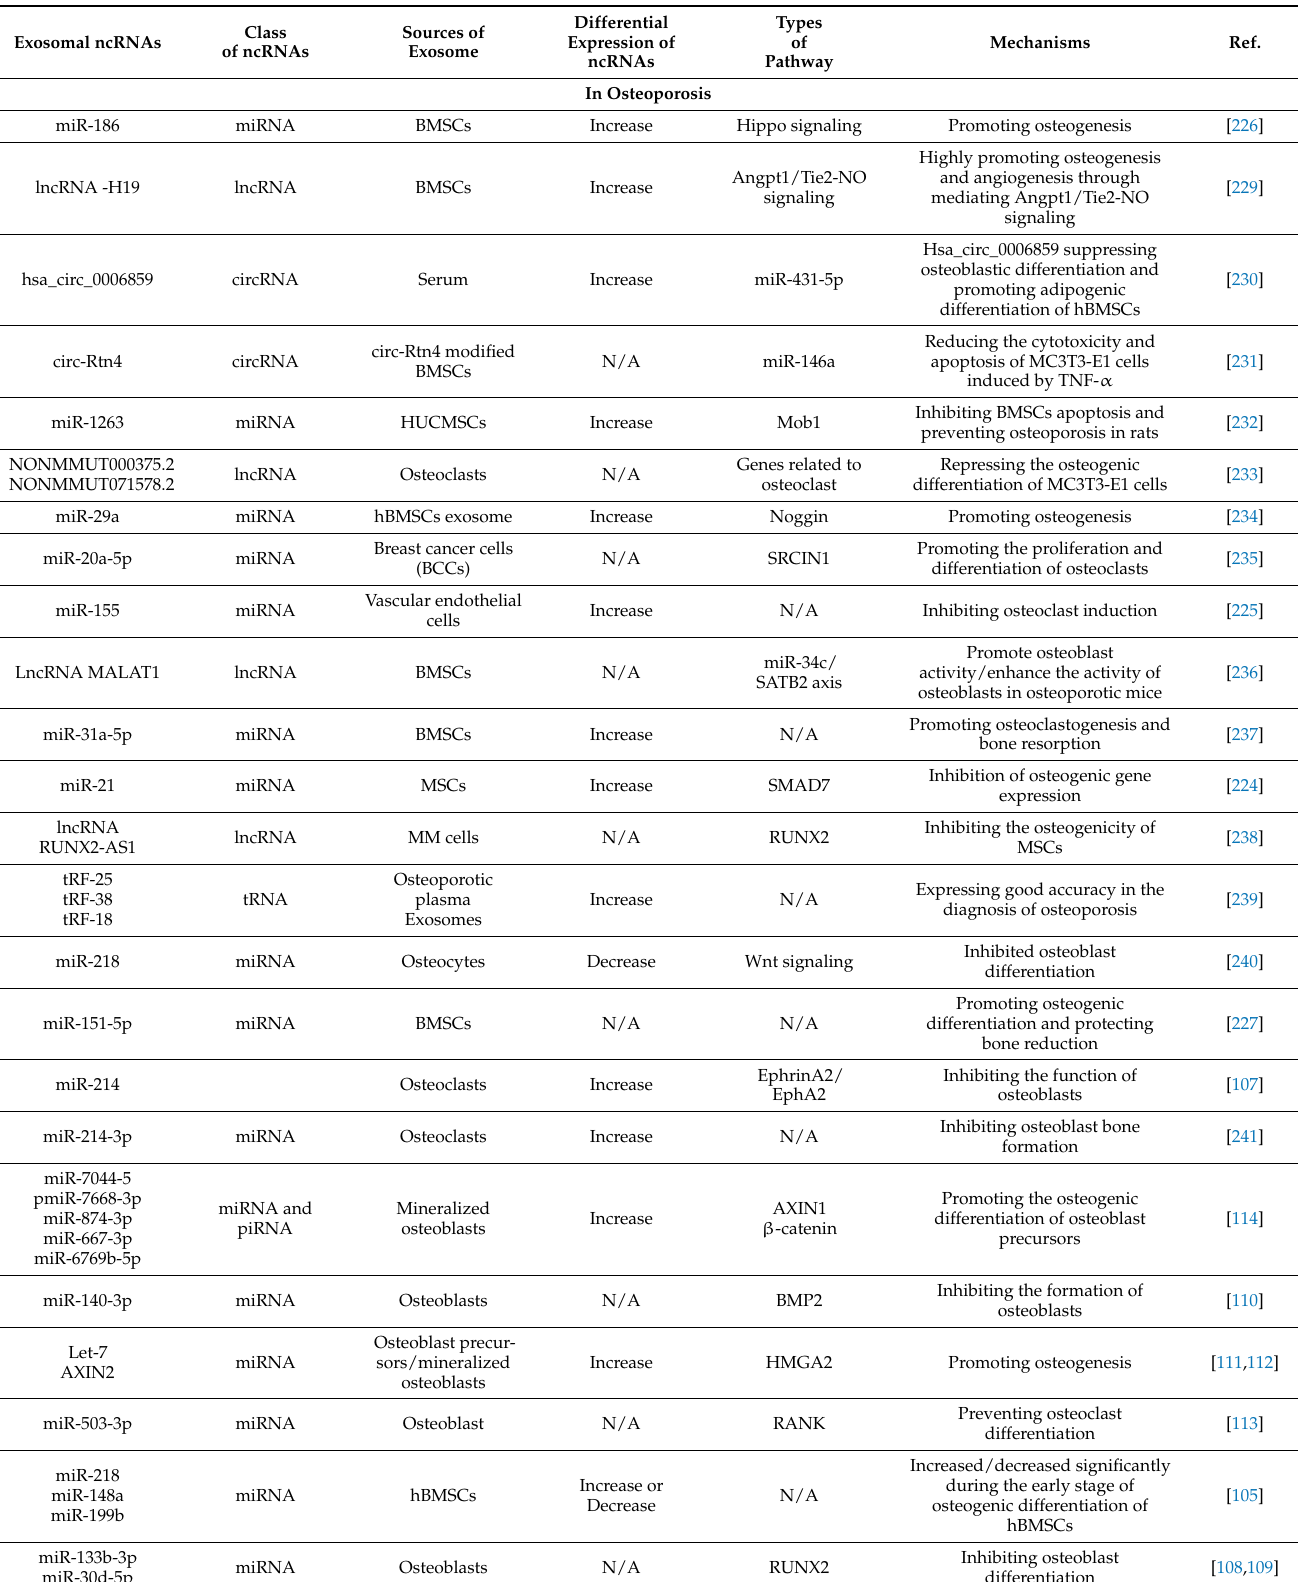
Table 1. Differential expression and regulation of exosomal ncRNAs in osteoporosis, osteoarthritis, and bone fracture repairing/healing by the different